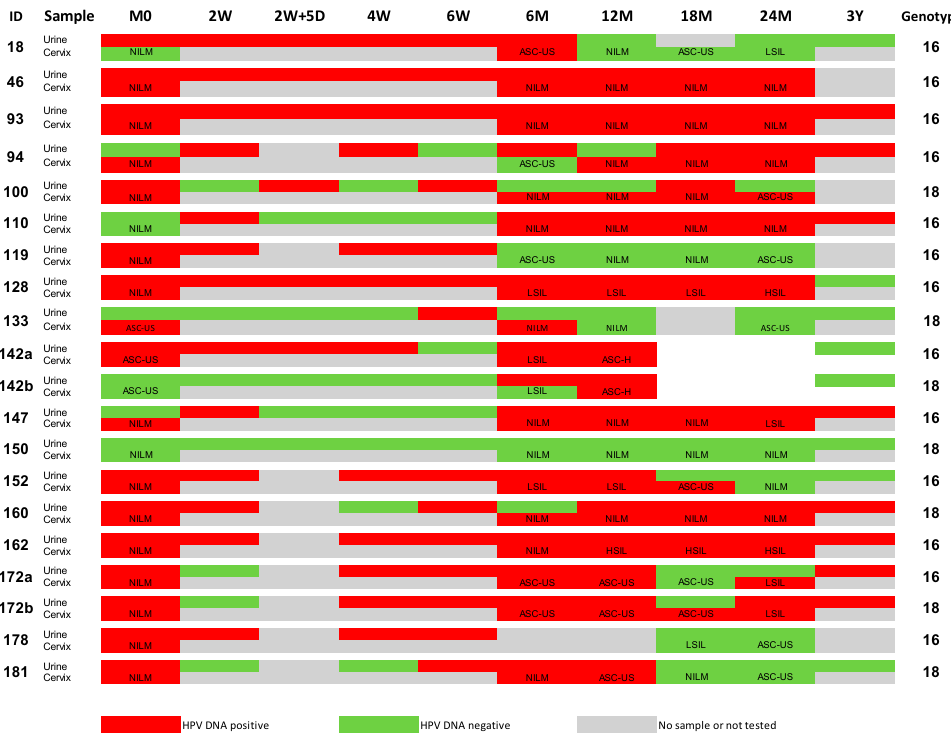
Figure 1. Schematic overview of HPV DNA results over the three-year follow-up period. The results obtained for home-collected samples are not included, but these results are provided in Figure S4. The sample ID of the participants is shown in the left column, and the HPV DNA results are provided for each participant; red: positive, green: negative. The top row also indicates the time-point of sampling during follow-up. M0 (month 0, start of the trial), W: week, D: days, Y: years. The right column indicates the HPV genotype—16 or 18. If a participant had HPV16 and HPV18 co-infection, the results for both genotypes are provided (e.g., 142a and 142b). The cytological results are provided for each collected cervical sample: NILM (Negative for Intraepithelial Lesion or Malignancy), ASC-US (Atypical Squamous Cells of Unknown Significance), ASC-H (Atypical Squamous Cells of